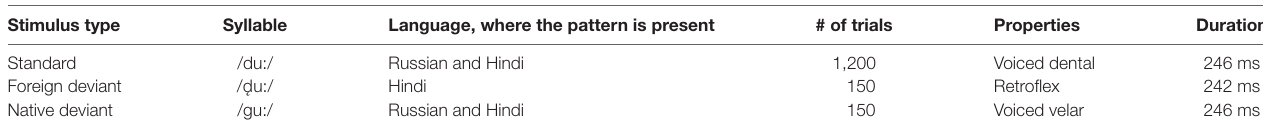
TABLE 1 | Types of auditory stimuli in the event-related potential (ERP)